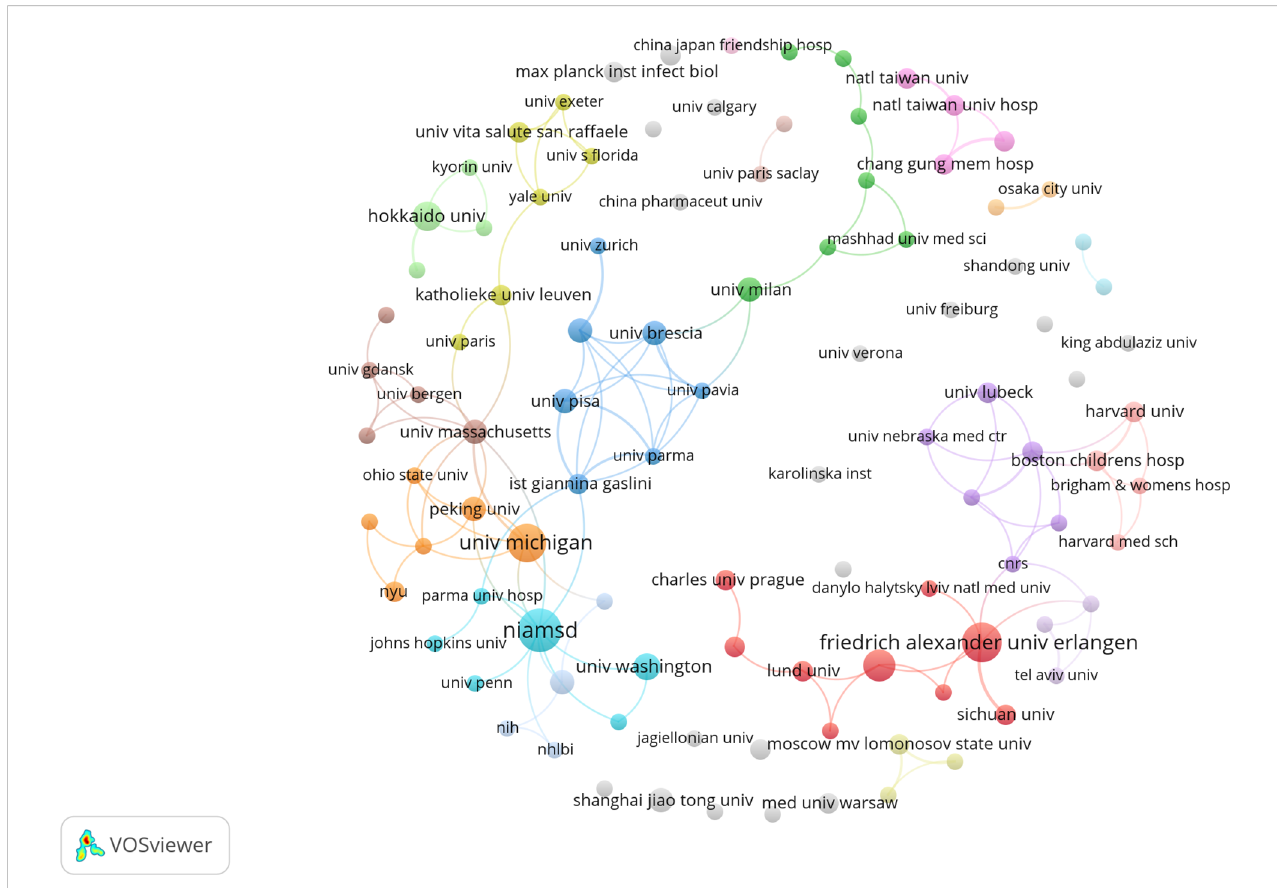
FIGURE 4 Visualization of organizations related to NETs in AIDs